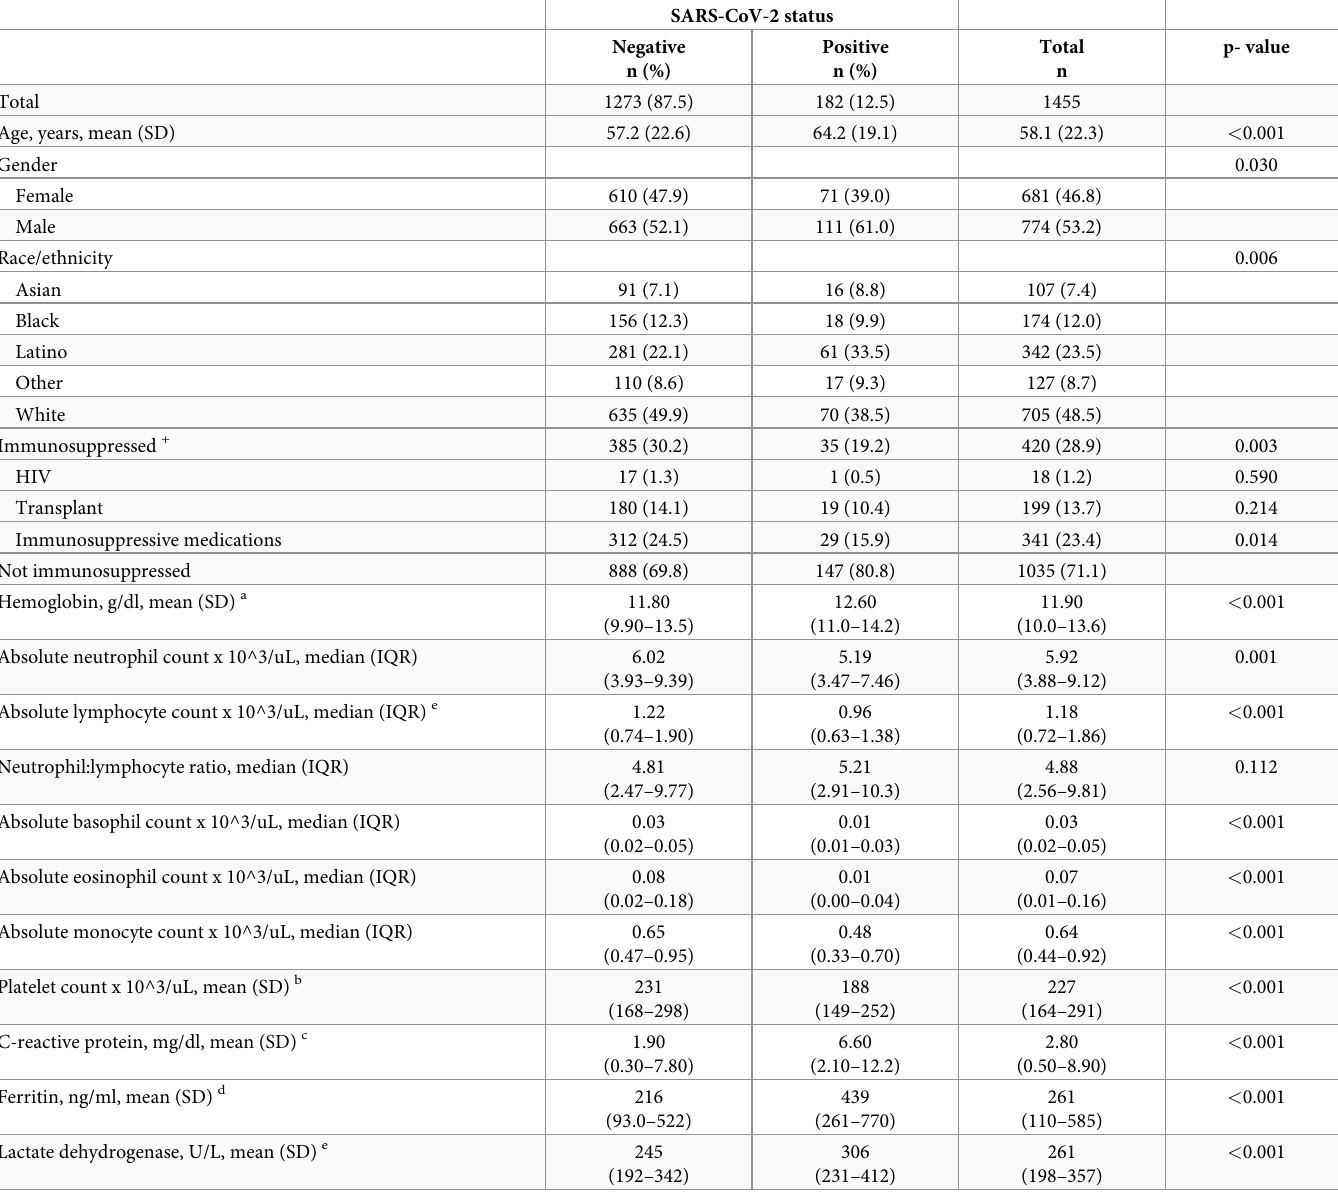
Table 1. Characteristics of cases by SARS-CoV-2